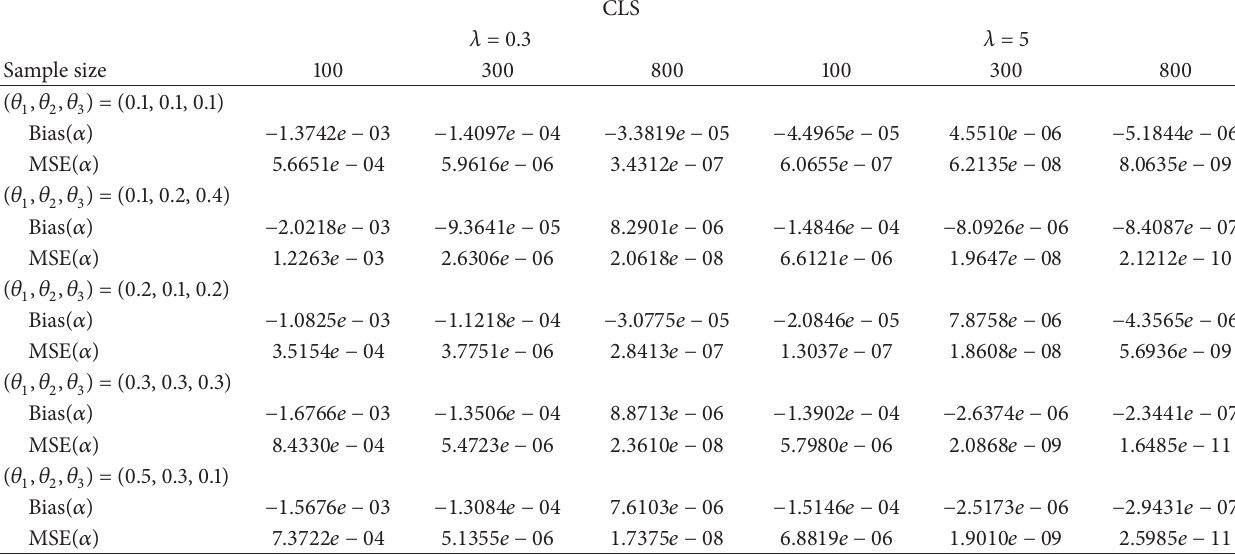
Table 3: Bias and MSE results of 𝛼 for NSINARMA(1,3)